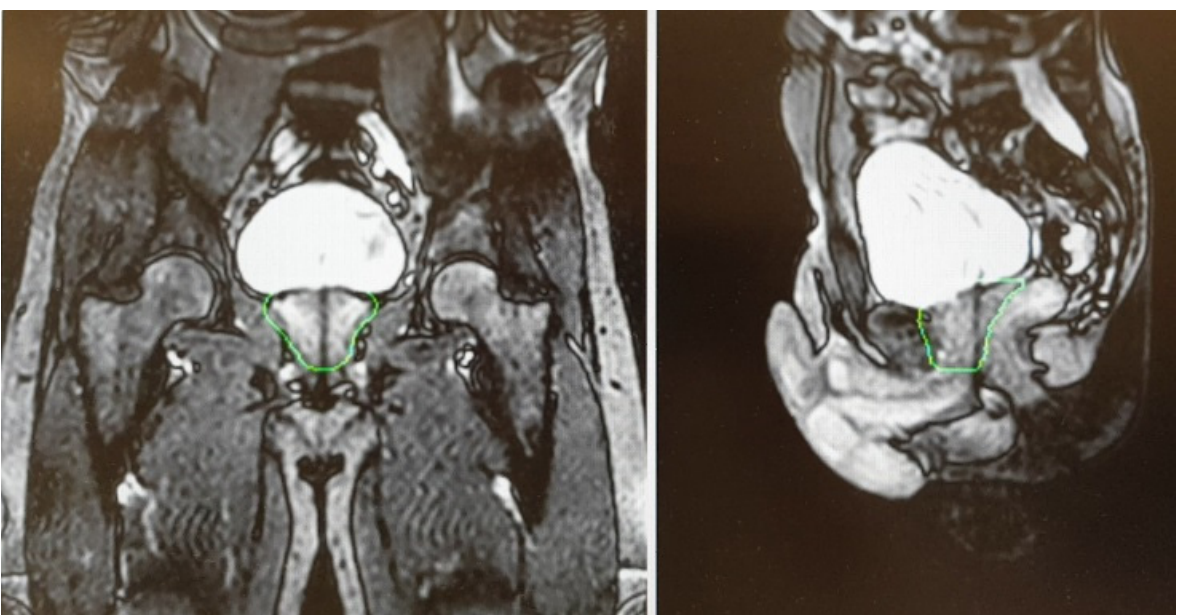
Figure 3. Cine Magnetic Resonance (CineMR) sequence before the delivery of MR-guided SBRT.